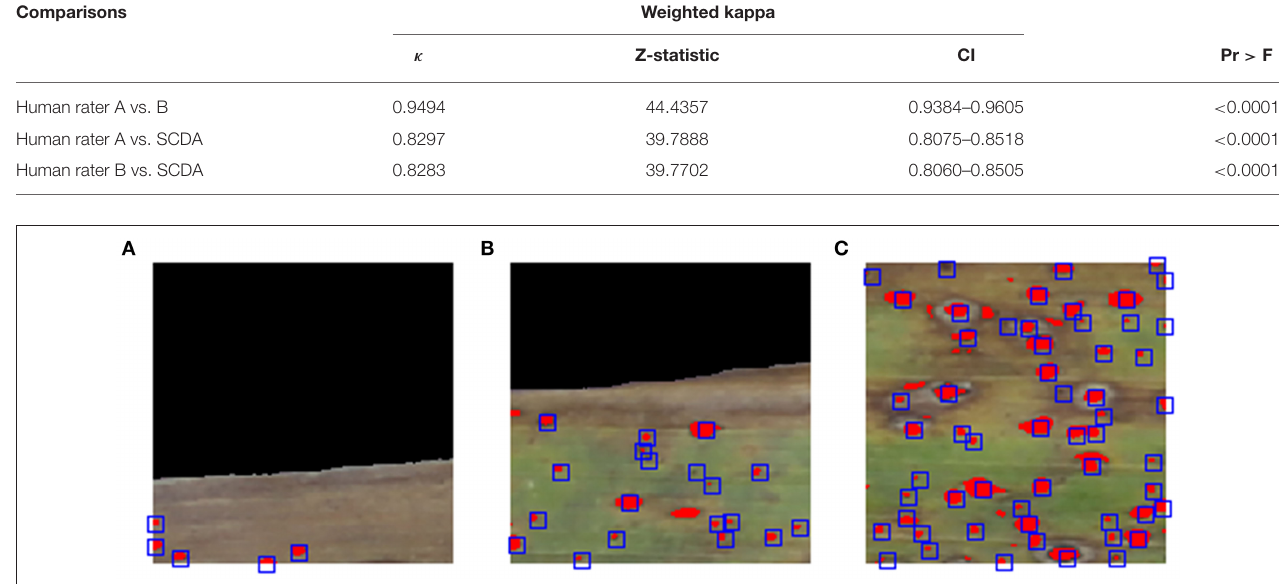
image are different in general. That is why we applied the